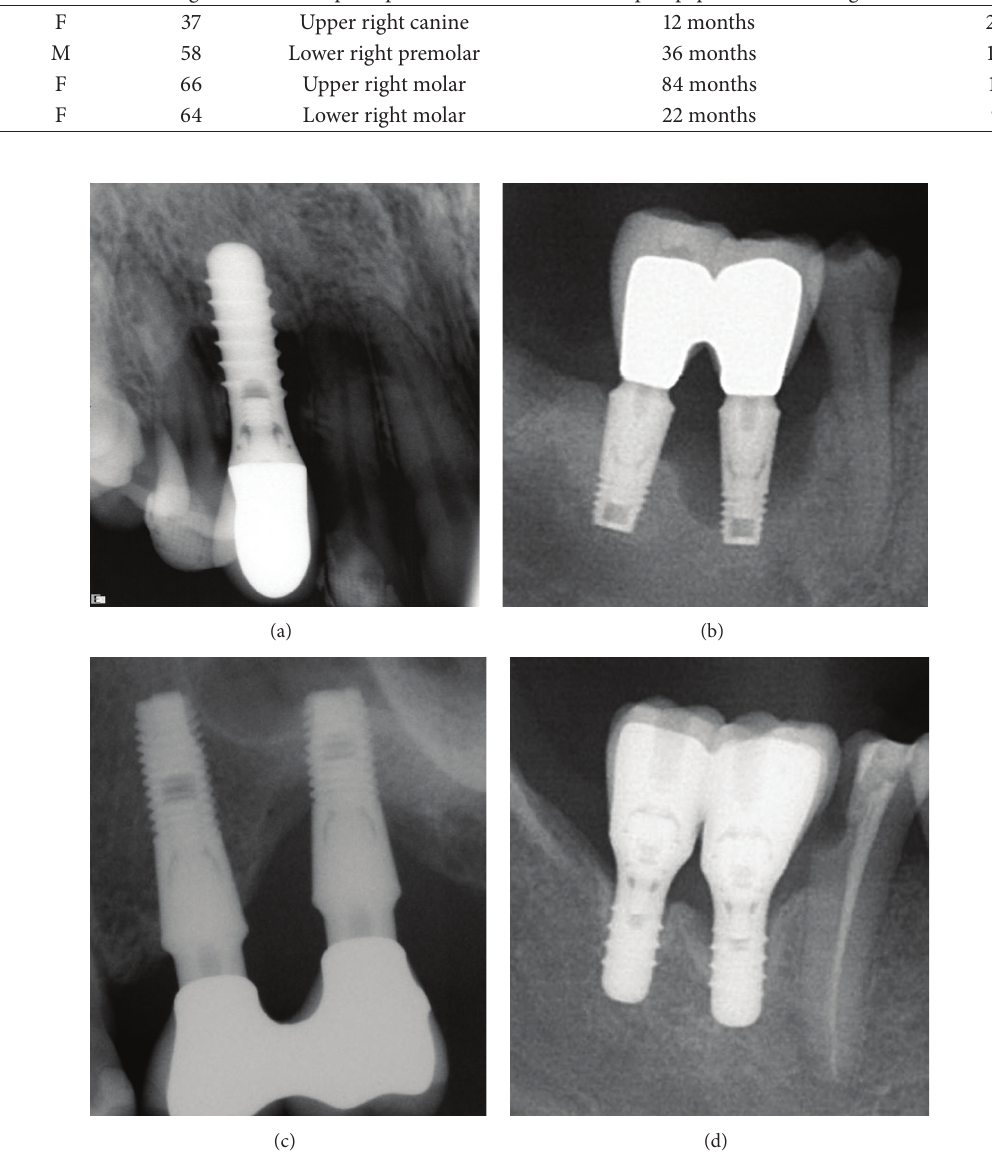
Figure 1: Preoperative radiological situation in subjects